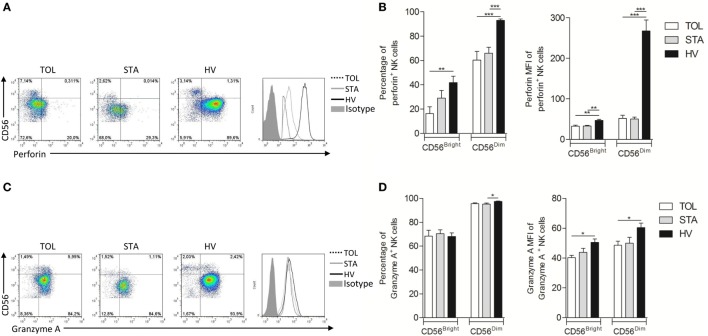
(A) Representative dotplot of perforin expression in tolerant patient (TOL) (left), STA (middle), and healthy volunteers (HV) (right); and histogram of perforin expression in CD56Dim natural killer (NK) cells in TOL (dotted line), STA (gray line), HV (black line), and isotype control in the filled histogram. (B) Mean percentage with SEM of perforin+ NK cells and mean of MFI with SEM of perforin in NK cells in TOL (white bar) (n = 11), STA (gray bar) (n = 12), and HV (black bar) (n = 15) among CD56Bright or CD56Dim. (C) Representative dotplot of granzyme A expression in TOL (left), STA (middle), and HV (right); and histogram of granzyme A expression in CD56Dim NK cells in TOL (dotted line), STA (gray line), HV (black line), and isotype control in the filled histogram. (D) Mean percentage with SEM of granzyme A+ NK cells and mean of MFI with SEM of granzyme A in NK cells in TOL (white bar) (n = 11), STA (gray bar) (n = 12) and HV (Black bar) (n = 15) among CD56Bright or CD56Dim. (Median and range are given in Table S1 in Supplementary Material.). Significance was defined as *p < 0.05, **p < 0.01, ***p < 0.001, and ****p < 0.0001.